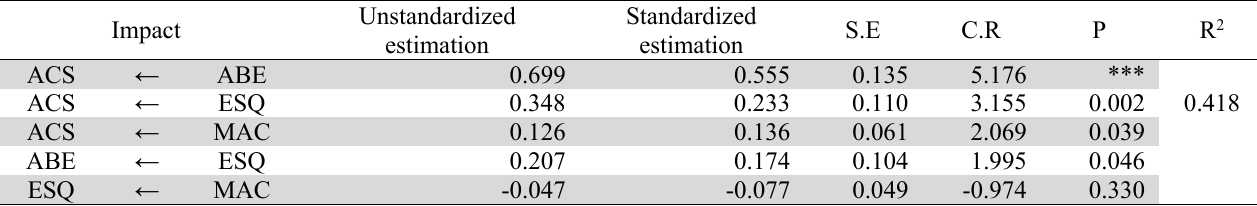
Regression analysis and hypothesis